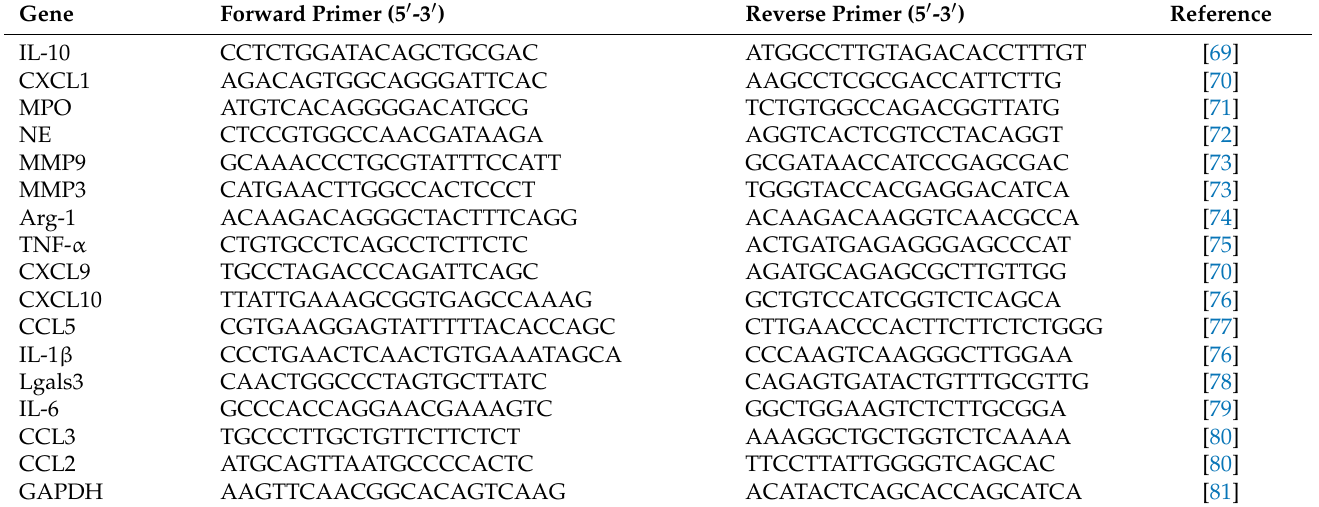
Table 1. Primers used in this